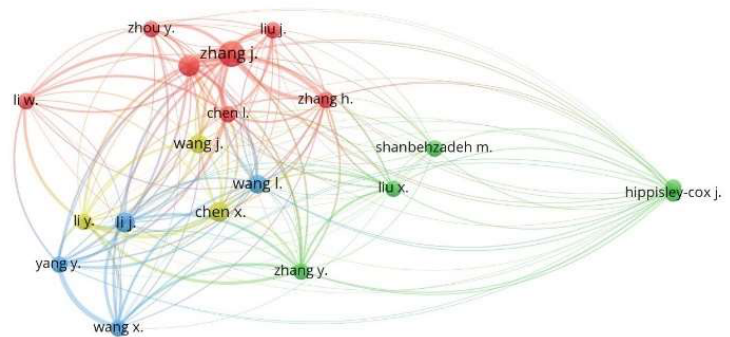
Figure 7. Bibliographic coupling between authors. Three clusters, red (top), blue (bottom), and green (right), correspond to all authors working in similar research fields. ML was applied to COVID-19, and the same sources in their reference lists were cited.